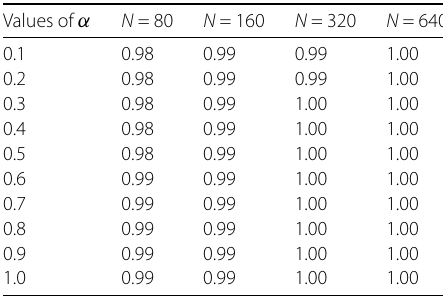
Table 2 Rates of convergence for Example 5.1 with r = 0.055 and δ = 0.065 Values of α